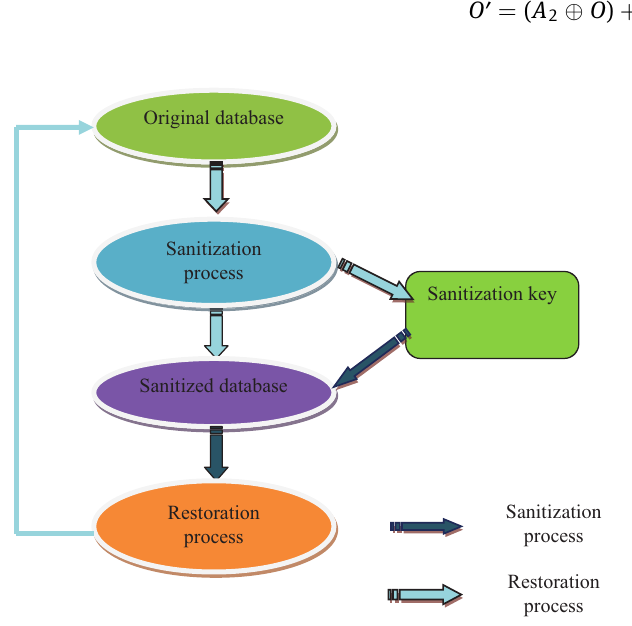
Figure 1: Overall Framework of the Proposed Data Preservation